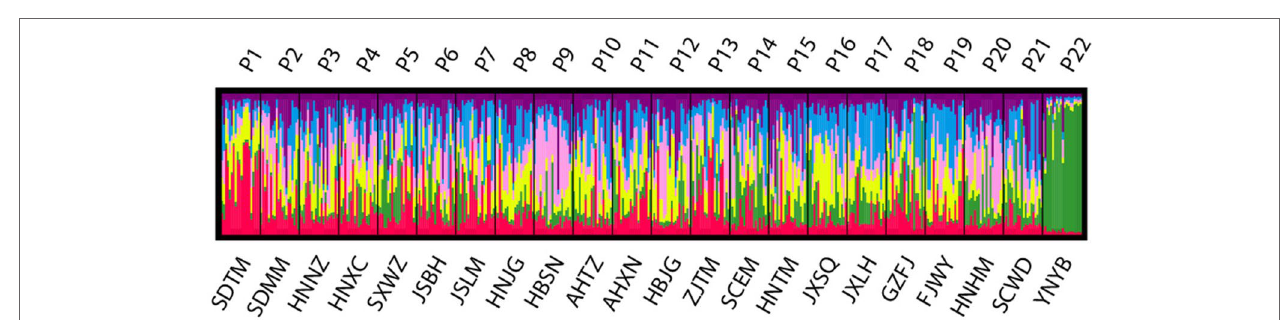
FIGURe 5 | Estimated genetic structure for K = 6 obtained with the program STRUCTURE for 22 populations of Pterocarya stenoptera based on simple sequence repeat (SSR) data. Each vertical bar represents an individual and its assignment proportion into one of five (colored) population clusters ( K ).